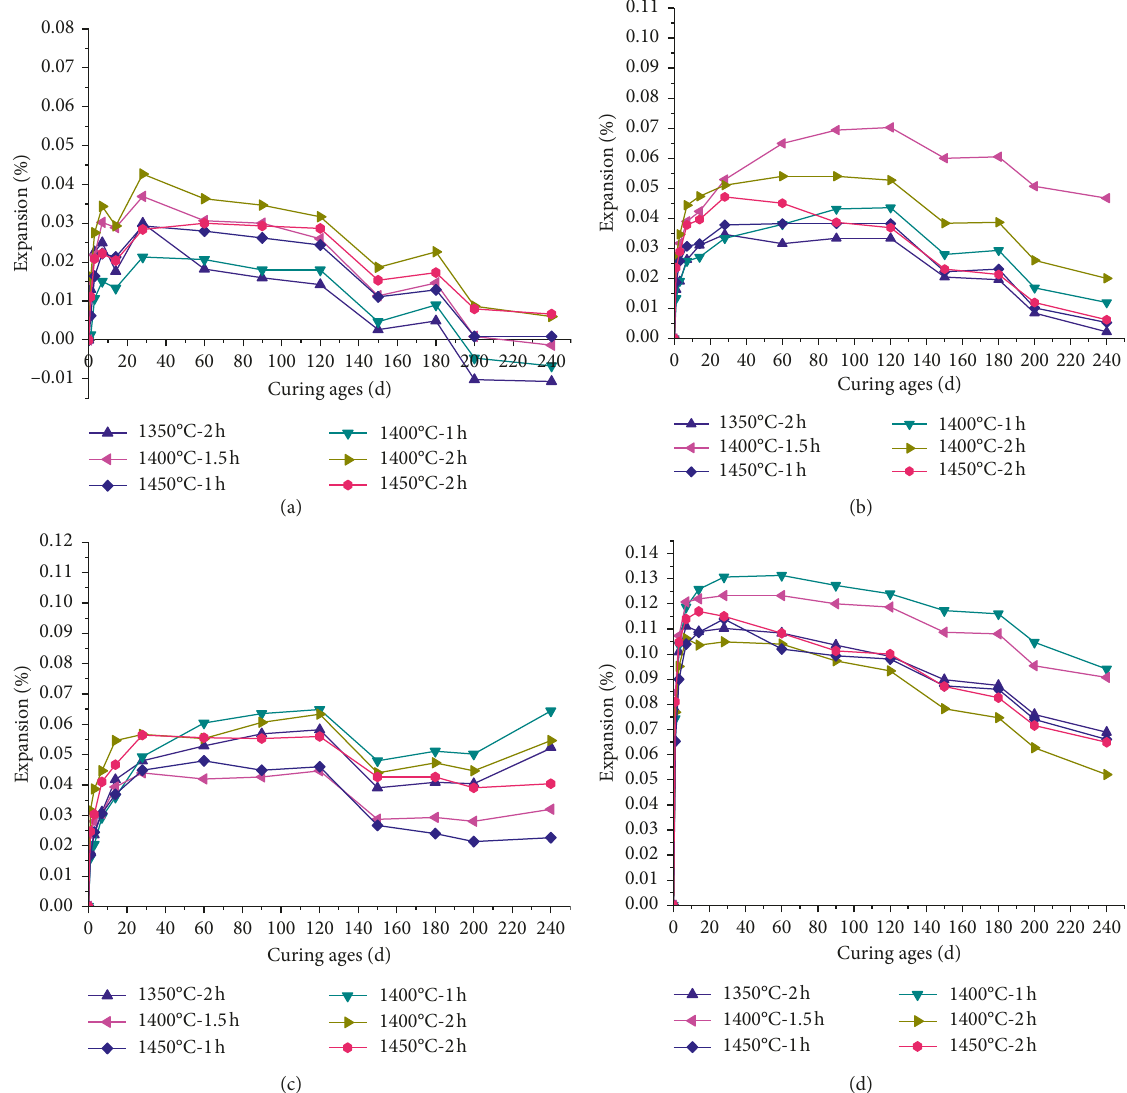
Figure 3: The expansion of LHC pastes prepared at different calcination conditions: (a) 20 ° C, (b) 30 ° C, (c) 40 ° C, and (d) 80 °